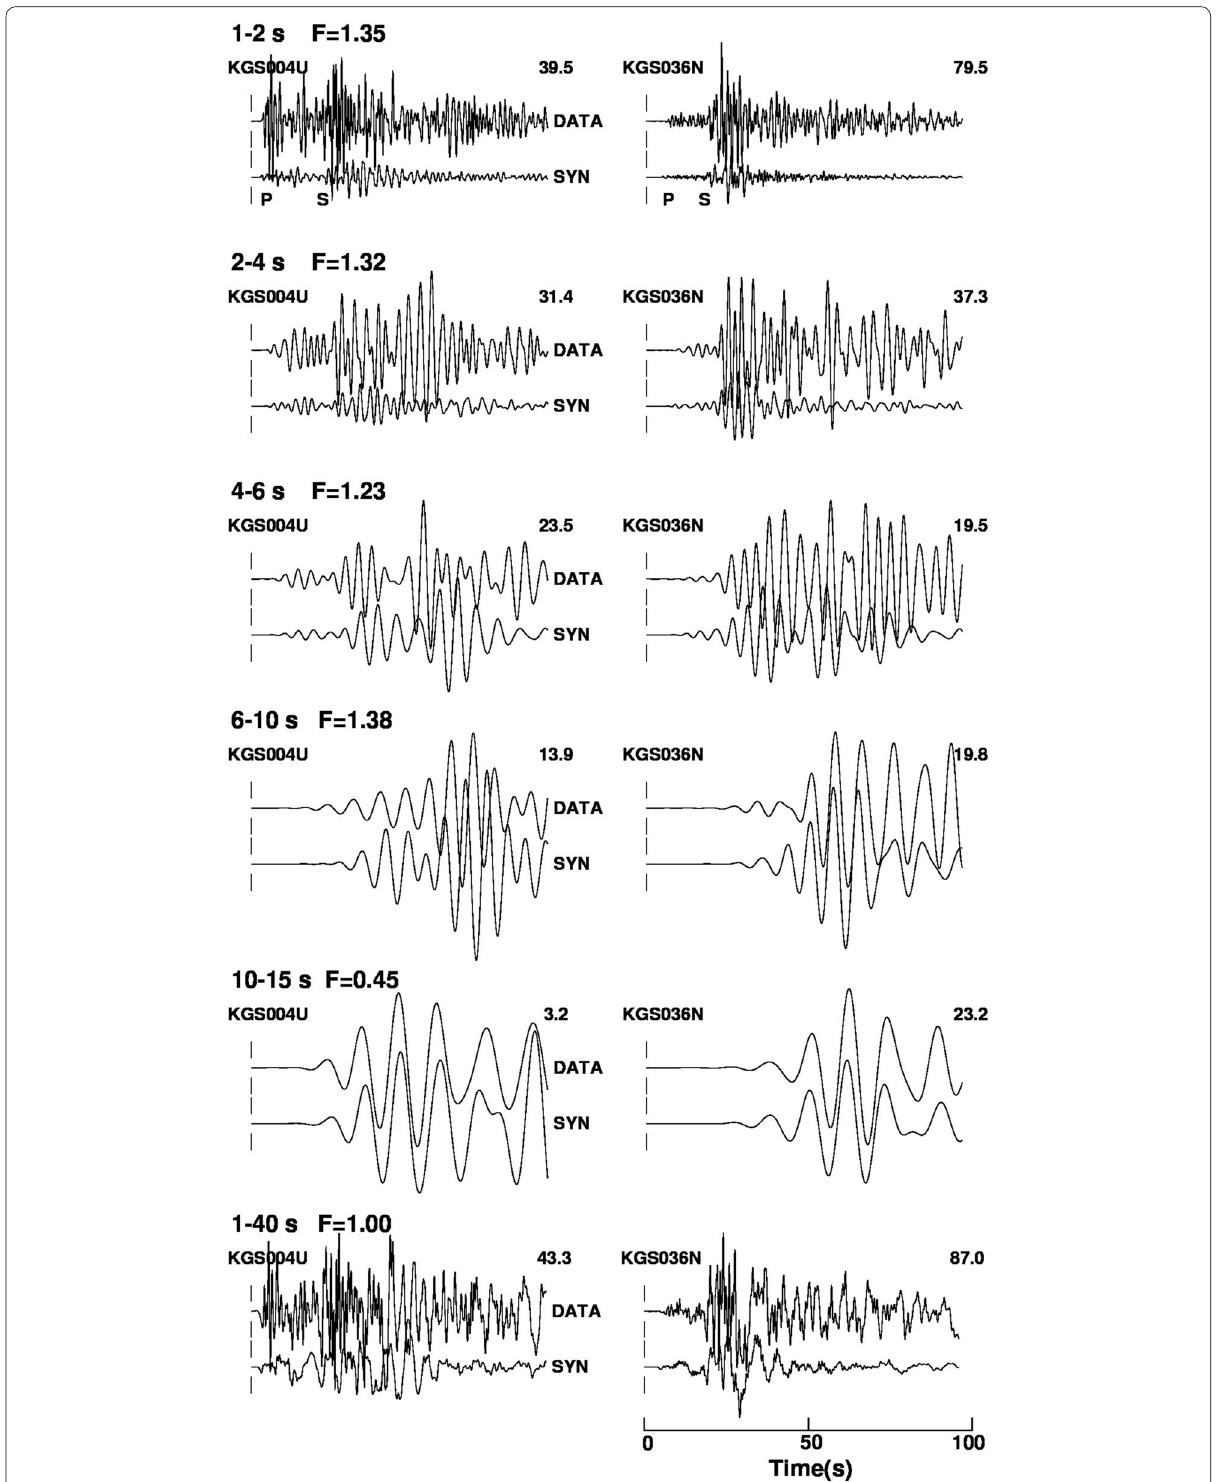
Fig. 5 Comparison of the observed and synthetic velocity waveforms for different passbands for EV2. Here we plot two typical components as an example (for all components see Additional file 1: Figure S4). FAMT parameters are used to generate the synthetic waveforms. The passbands and the normalized residuals ( F in Eq. 2) for all the thirteen components used in this analysis are attached to each trace. The symbols “P” and “S” at the top traces denote the onset of P - and S -wave packets,